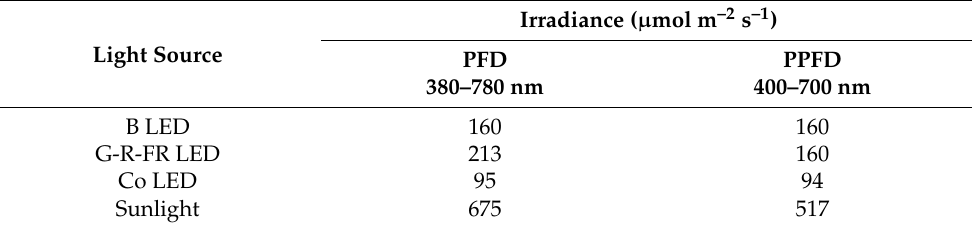
Table 4. The total photon flux density (PFD) and photosynthetic photon flux density (PPFD) of the LED light sources. Indicative maximum solar light level recorded at 13:00 (solar midday) 5 July 2021 above control treatment plants.